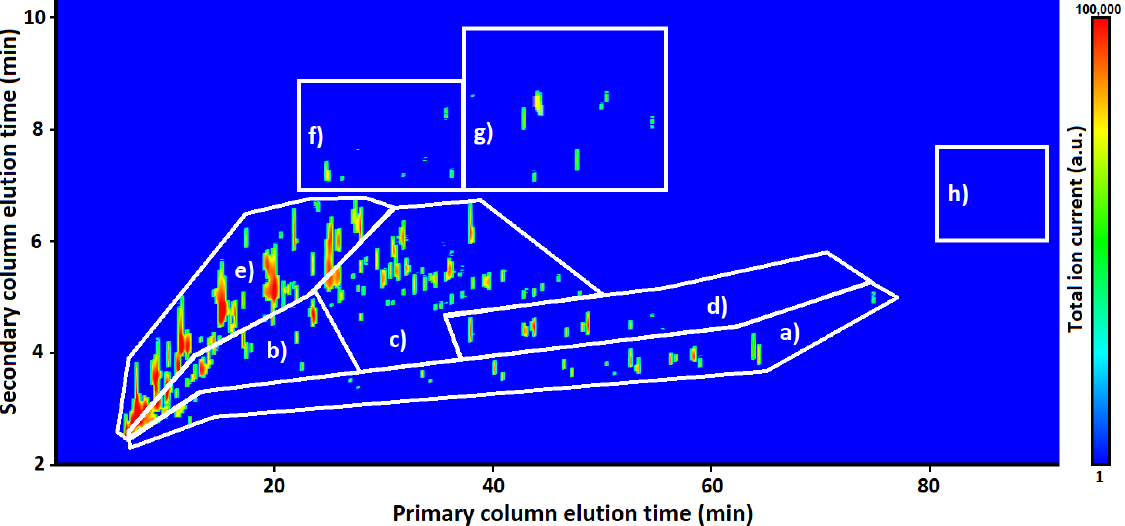
Figure 2. A 2D-GC-MS chromatogram of a WWHTLB sample dissected into several key regions relating to: ( a ) hydrocarbons; ( b ) aromatics, pyrroles, and phenols; ( c ) benzenamines, N-containing